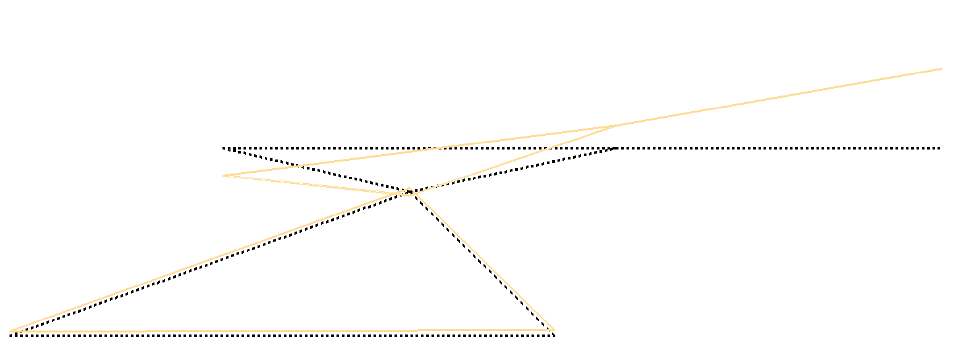
Figure 6. Modal shape of the in-plane torsional mode for the steel specimen case.